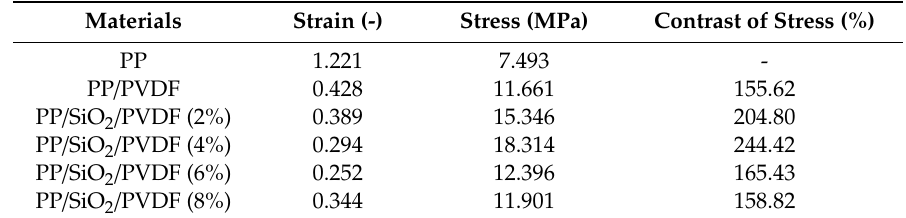
Figure 3. Stress strain curve and bar chart of tensile test: ( a ) stress strain curve and ( b ) maximum stress bar chart. Table 1. Comparison of maximum stress and strain.